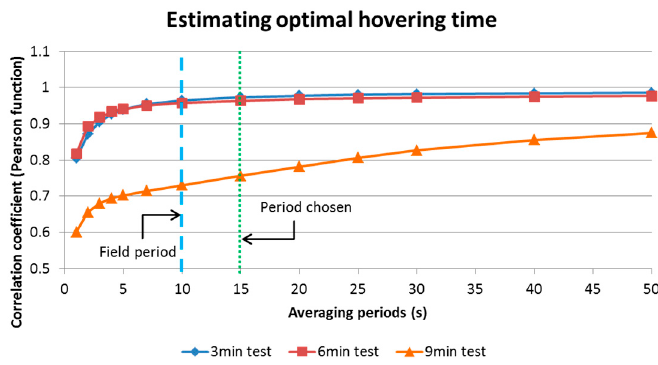
Figure 15. Calculated correlation coefficients ( r ) for different averaging periods of PM 10 concentrations for three sets of tests.